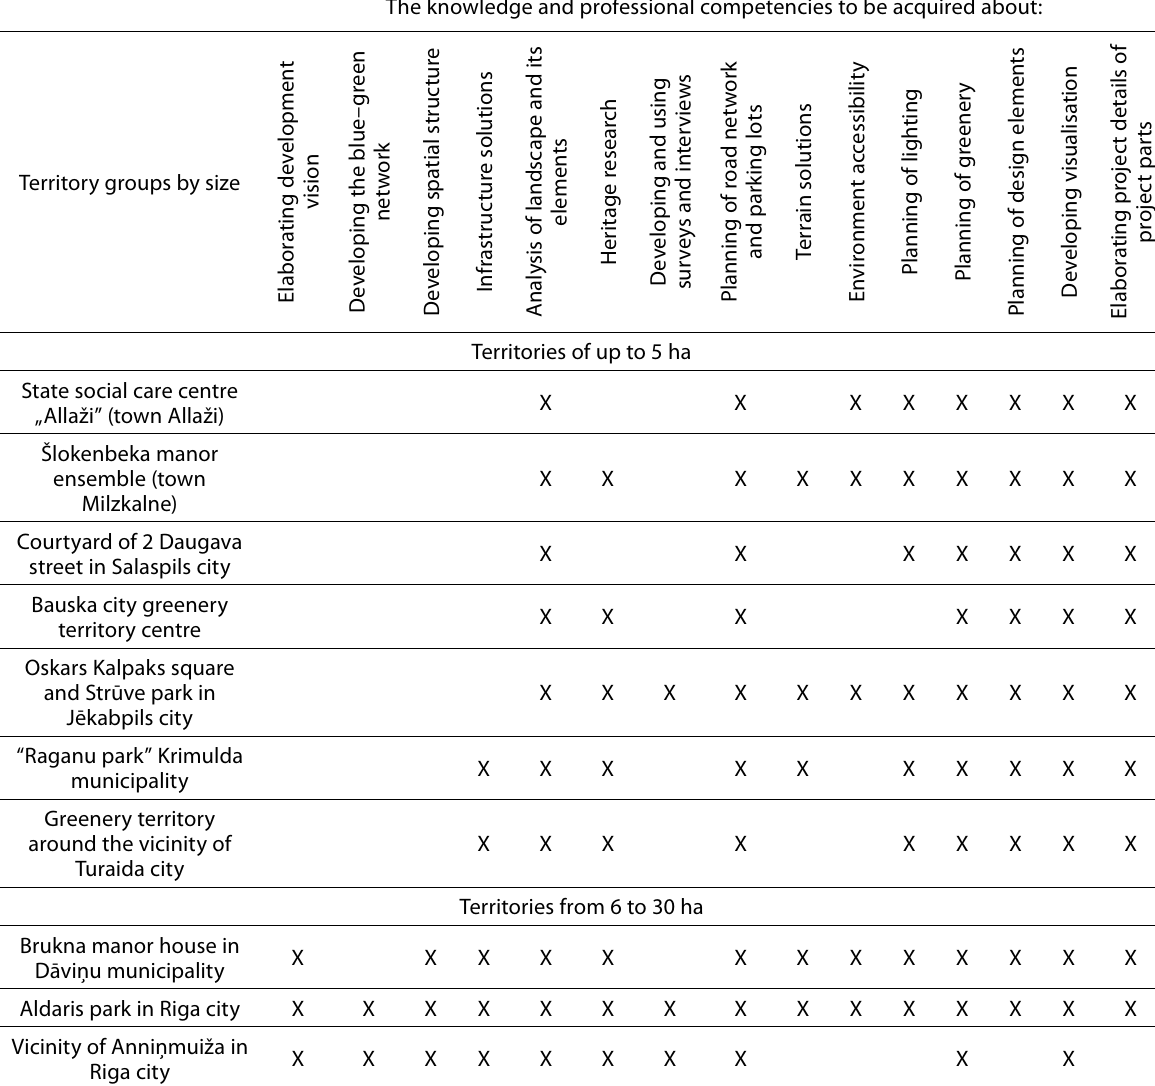
Table 1. The knowledge and professional skills The knowledge and professional competencies to be acquired about: